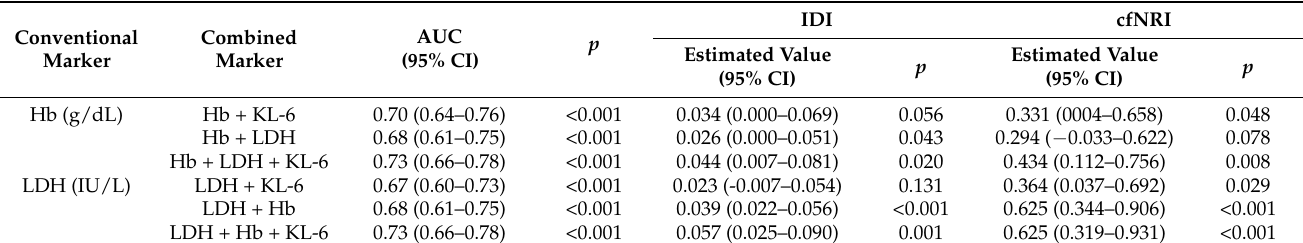
Figure 2. Receiver operator characteristic curve analyses for predicting more than 1 grade of reticulin. Hb, LDH, and KL-6 were comparable to predict more than 1 grade of reticulin (AUC ranging from 0.60 to 0.62); their combination was superior to each marker, showing improved prediction ( p = 0.006 vs. Hb; p = 0.005 vs. LDH; p = 0.003 vs. KL-6). Abbreviations: Hb, hemoglobin; LDH, lactate dehydrogenase; KL-6, krebs von den lungen-6. Reclassification analyses confirmed that the combination of Hb, LDH, and KL-6 sig- nificantly increased the predictive ability for BMF compared with Hb or LDH alone (Table 3). The groups with the above cut-off values in Hb, LDH, and KL-6 showed a higher agree- Hb + , 74.3%; LDH + , 76.8%; KL6 + , 74.4%) (Figure 3). Table 3. Evaluation of the added predictive ability of KL-6 using integrated discrimination improve- ment and net reclassification improvement.